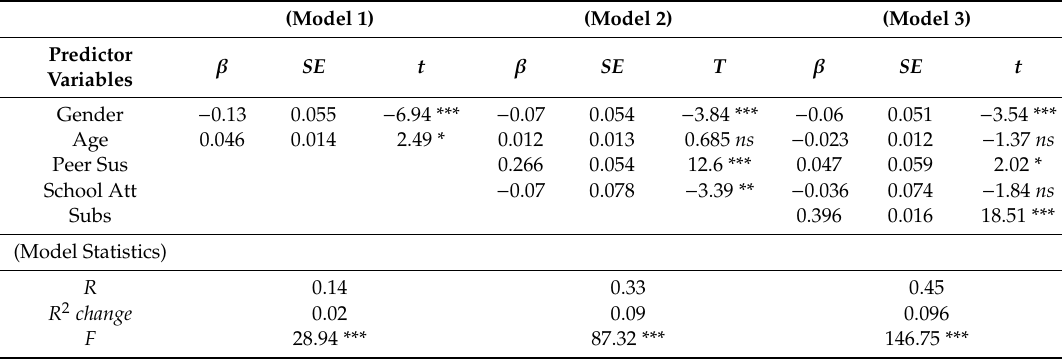
Table 3. Multiple regression analysis of sexual behavior predicted by school attachment, peer influence, and substance